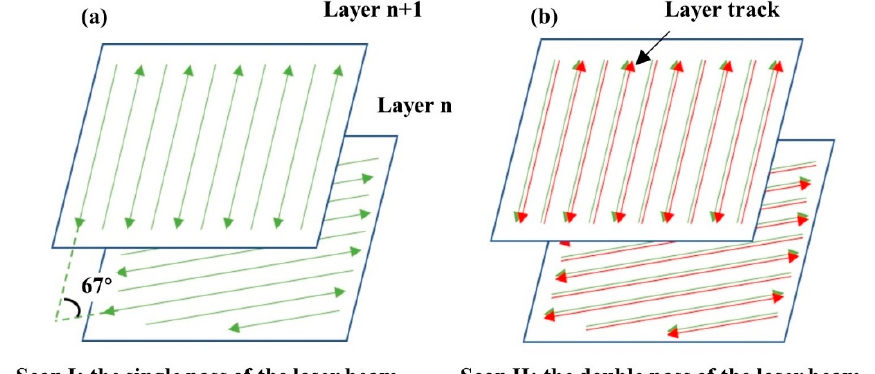
Figure 2. The scanning strategy of the specimens: ( a ) Single melting strategy, ( b ) remelting strategy.